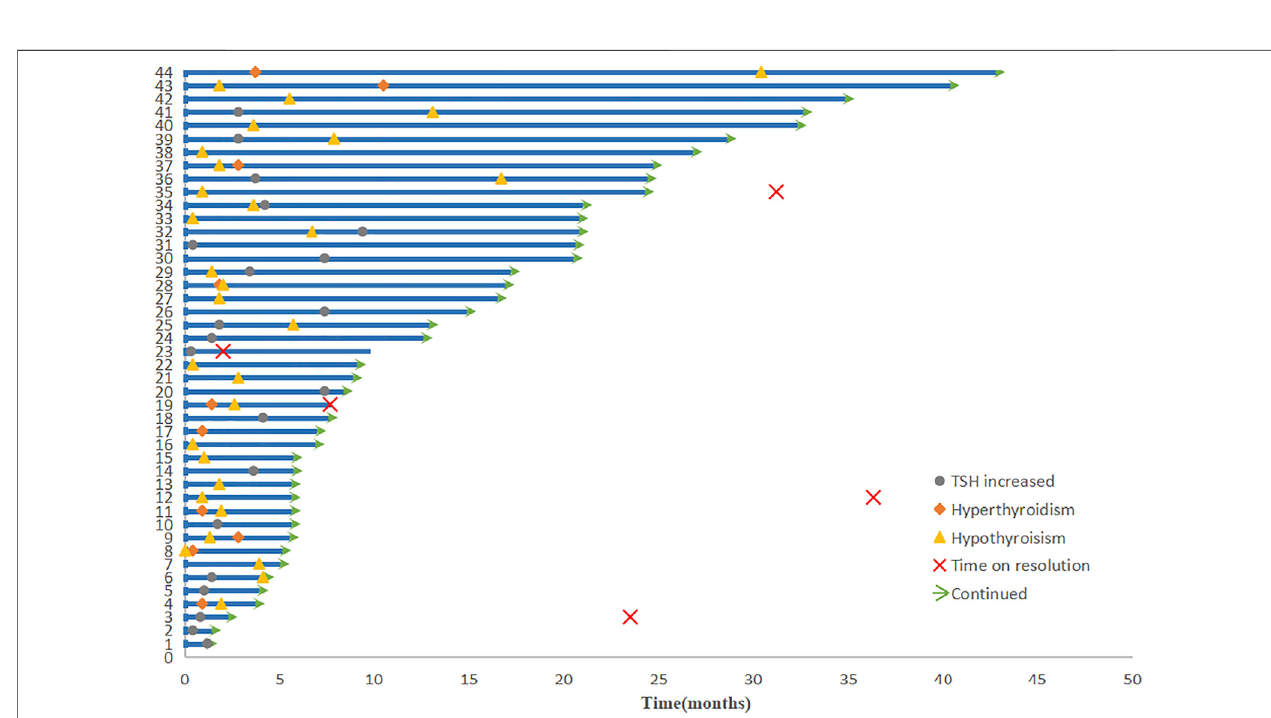
FIGURE 3 | Duration of treatment and onset and resolution of endocrine